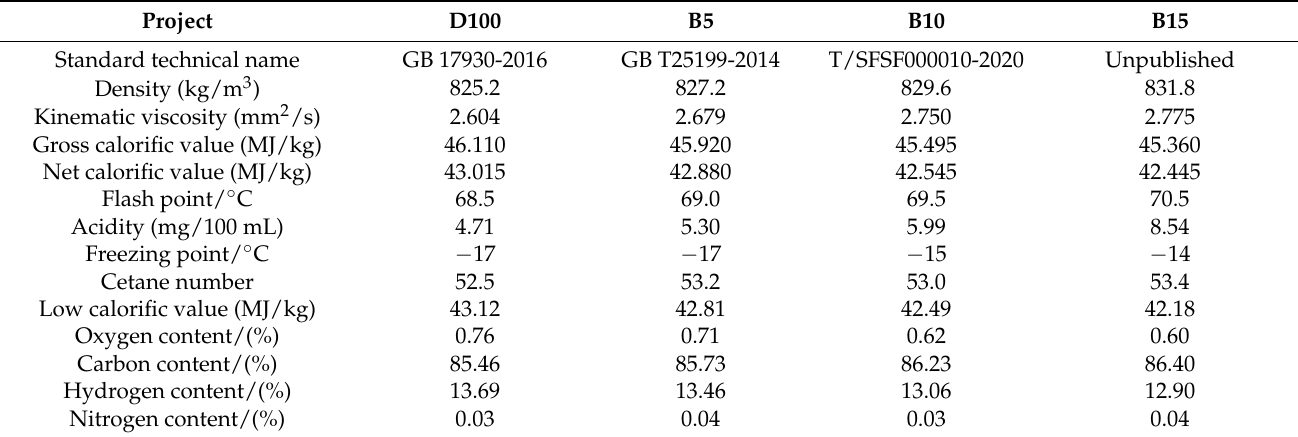
Table 3. Properties of different injection fuels.